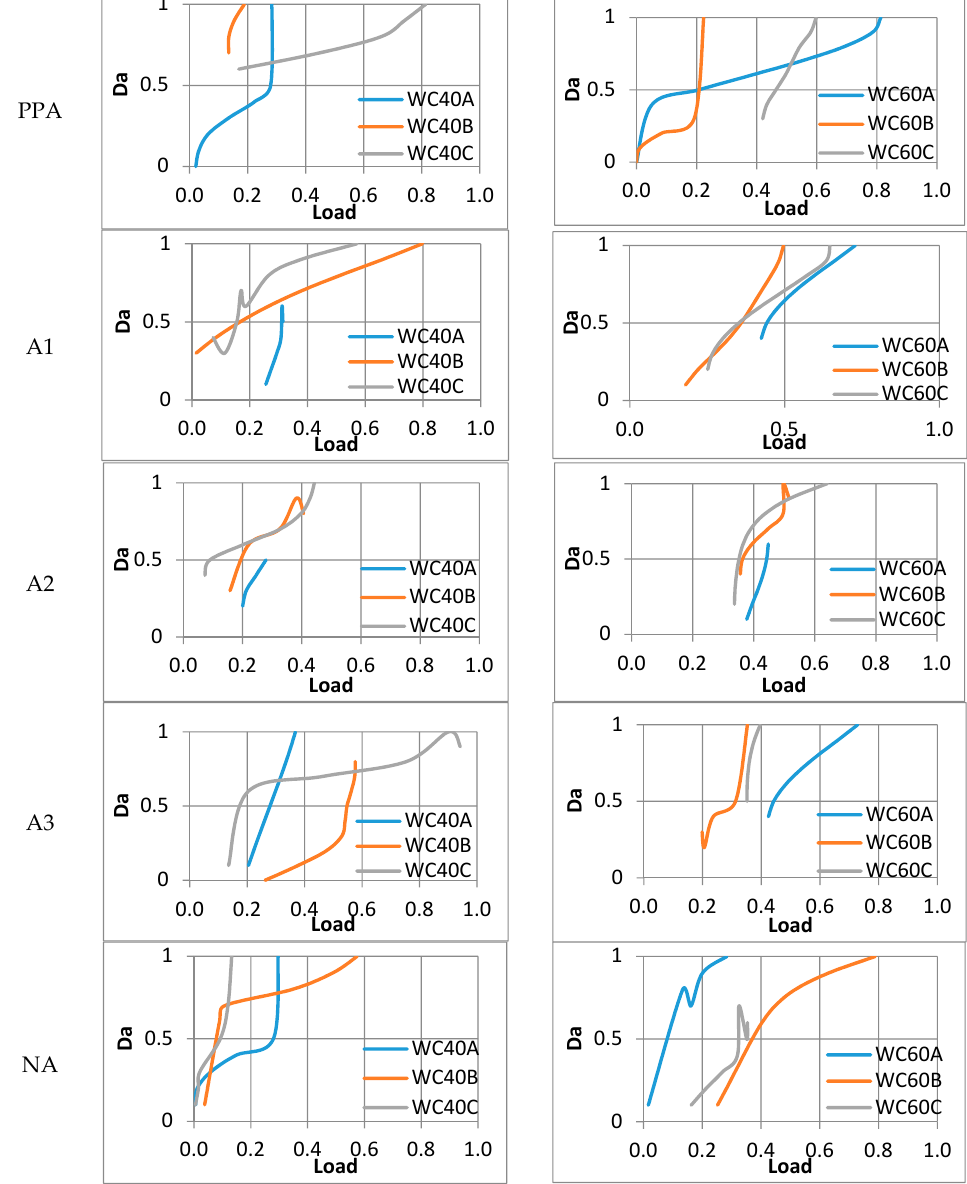
Figure 12. Sensitivity of all parameters simulated from optimum ANN models.